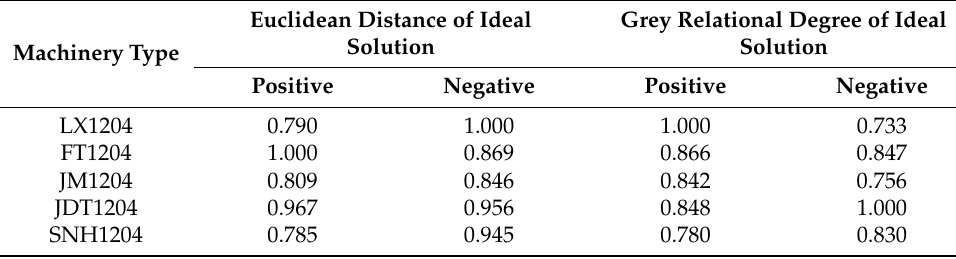
Figure 4. Correlation degree among indexes. Table 5. Euclidean distance and grey relational degree.